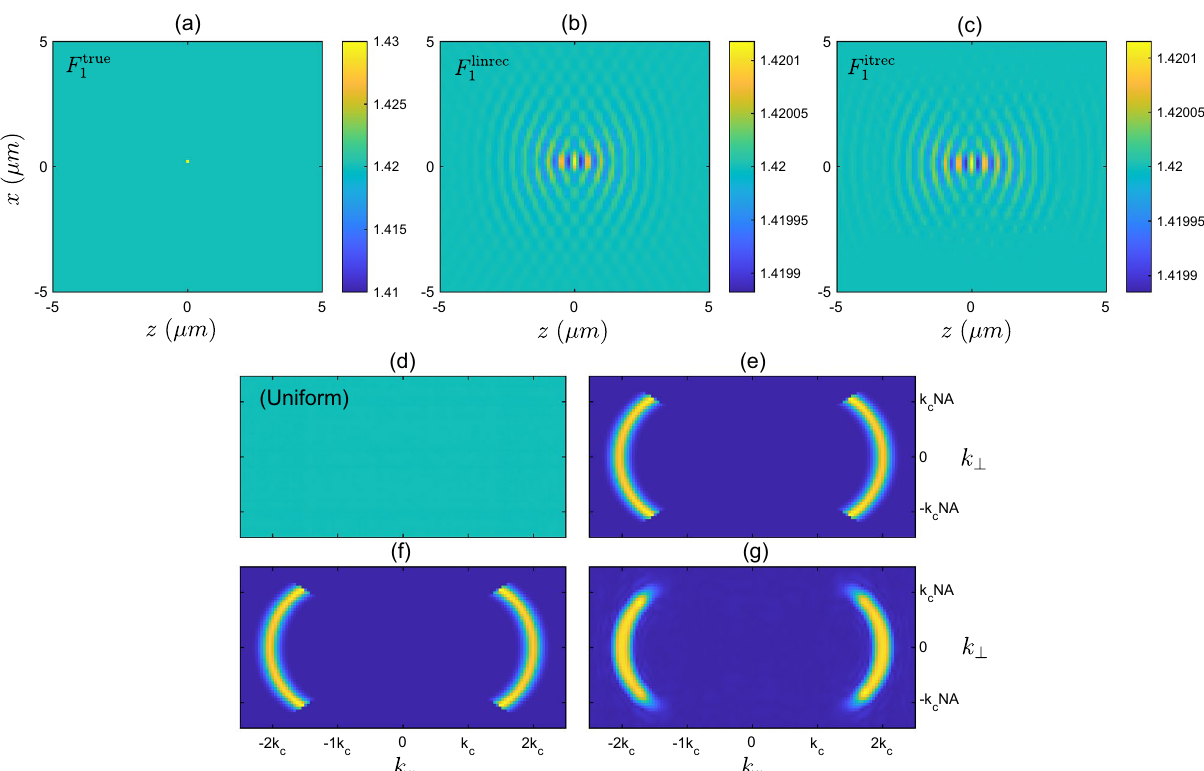
Figure 4. ( a ) Refractive index corresponding to the scattering potential of the point-like sample F 1 . ( b ) Refractive index corresponding to the linear reconstruction F linrec 1 . ( c ) Refractive index corresponding to the iterative solver reconstruction F itrec 1 . ( d ) Magnitude of Fourier transform, |˜ F true 1 ( k ) , of the true sample (which | ( k ) . ( f ) Magnitude of Fourier transform of true in this case is simply uniform). ( e ) Theoretical k -space filter, f � b ( k ) f � sample after being filtered |˜ F true 1 ( k ) , i.e. ( d ) multiplied by ( e ). ( g ) Magnitude of the Fourier transform b × | of the reconstructed sample provided by the iterative solver, |˜ F itrec 1 ( k ) |